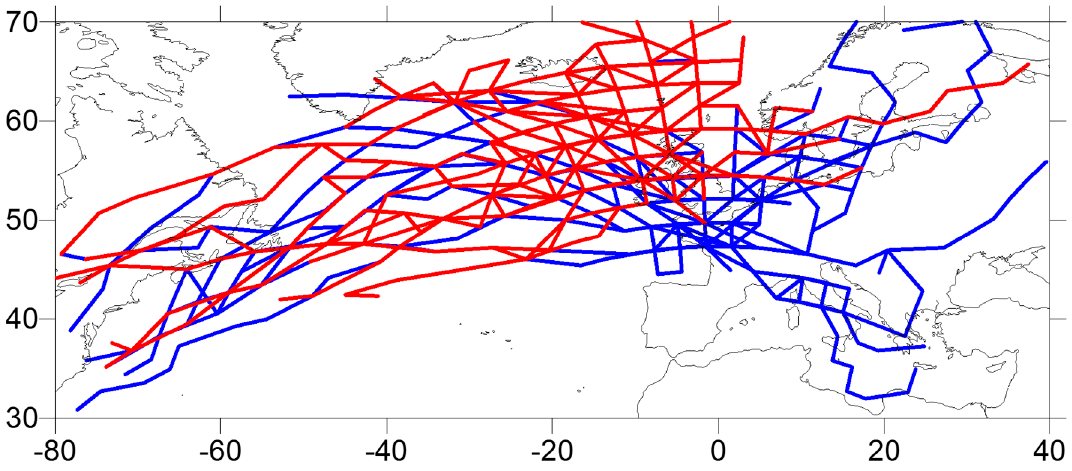
Figure 5. Storm tracks corresponding to wave storms belonging to Cluster 1 (red) and Cluster 2 (blue).